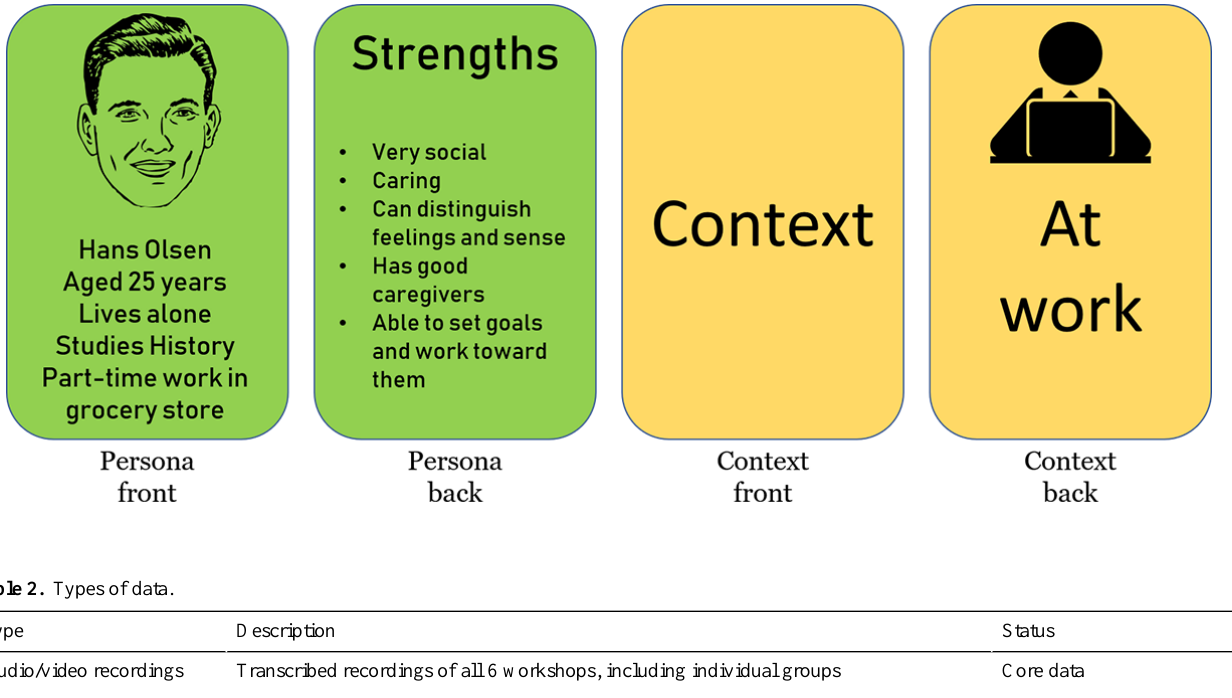
Figure 6. Cards for design game in second workshop.